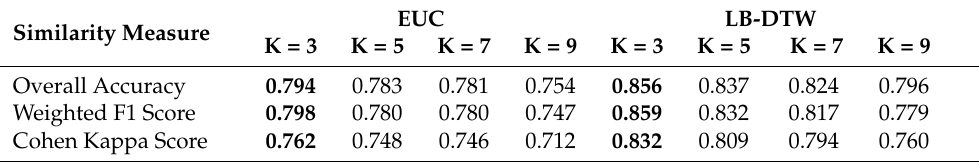
Table 8. Comparison of different K values for the fourth SITS grid.